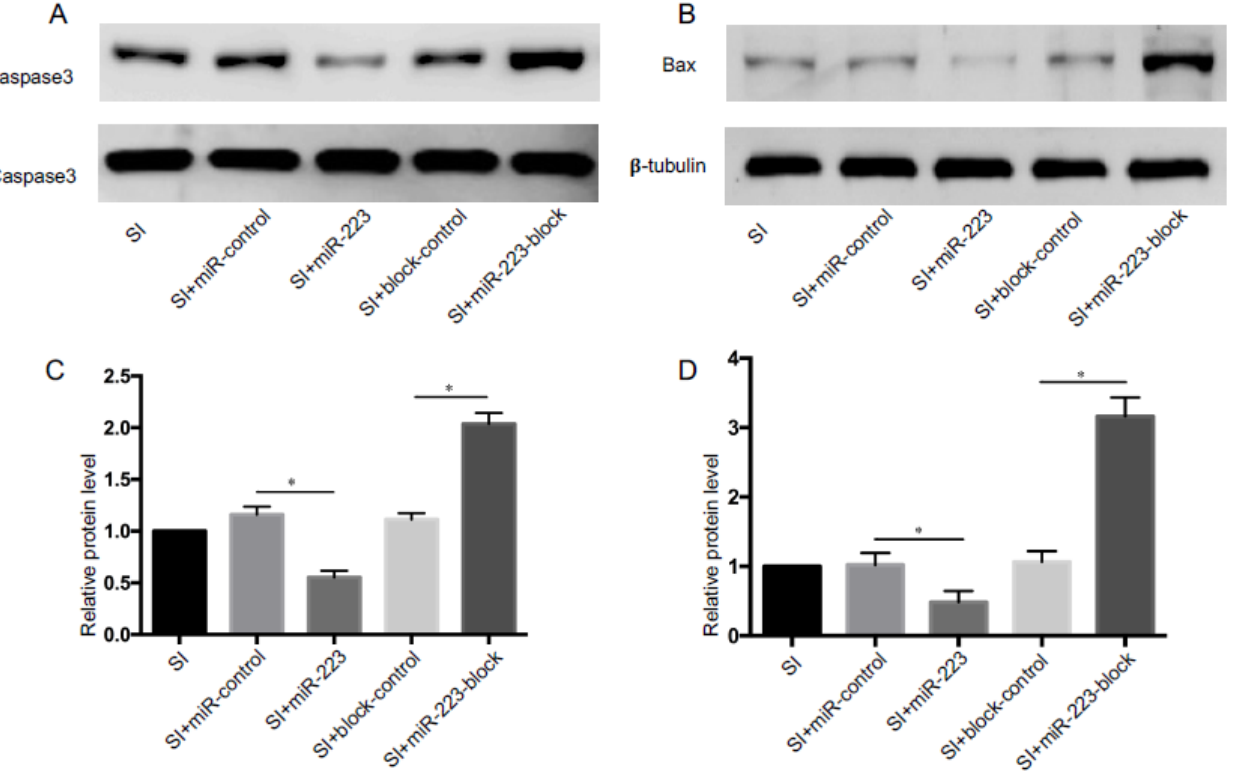
Figure 5. Effects of miR-223 on pro-apoptotic proteins in bEnd.3 cells after SI. Protein expression of cl-caspase-3/caspase-3 ( A ) and BAX ( B ) in Western blots. Bar graphs showing quantification of cl-caspase-3 ( C ) and BAX ( D ), n = 6 per group; data are presented as the mean ± SD; * p < 0.05, miR-223 versus miR-ontrol group, miR-223-block versus block-control group. miR-223: microRNA-223; cl-caspase-3: cleaved-caspase-3; SI: stretch injury.